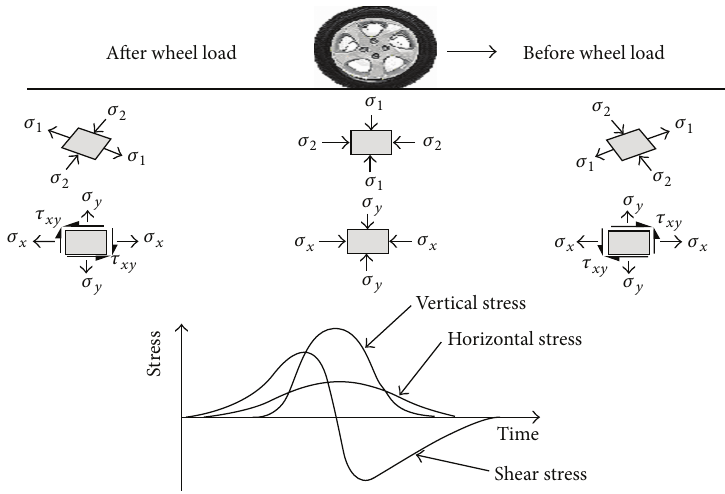
Figure 1: Stress beneath a rolling wheel load after [16].